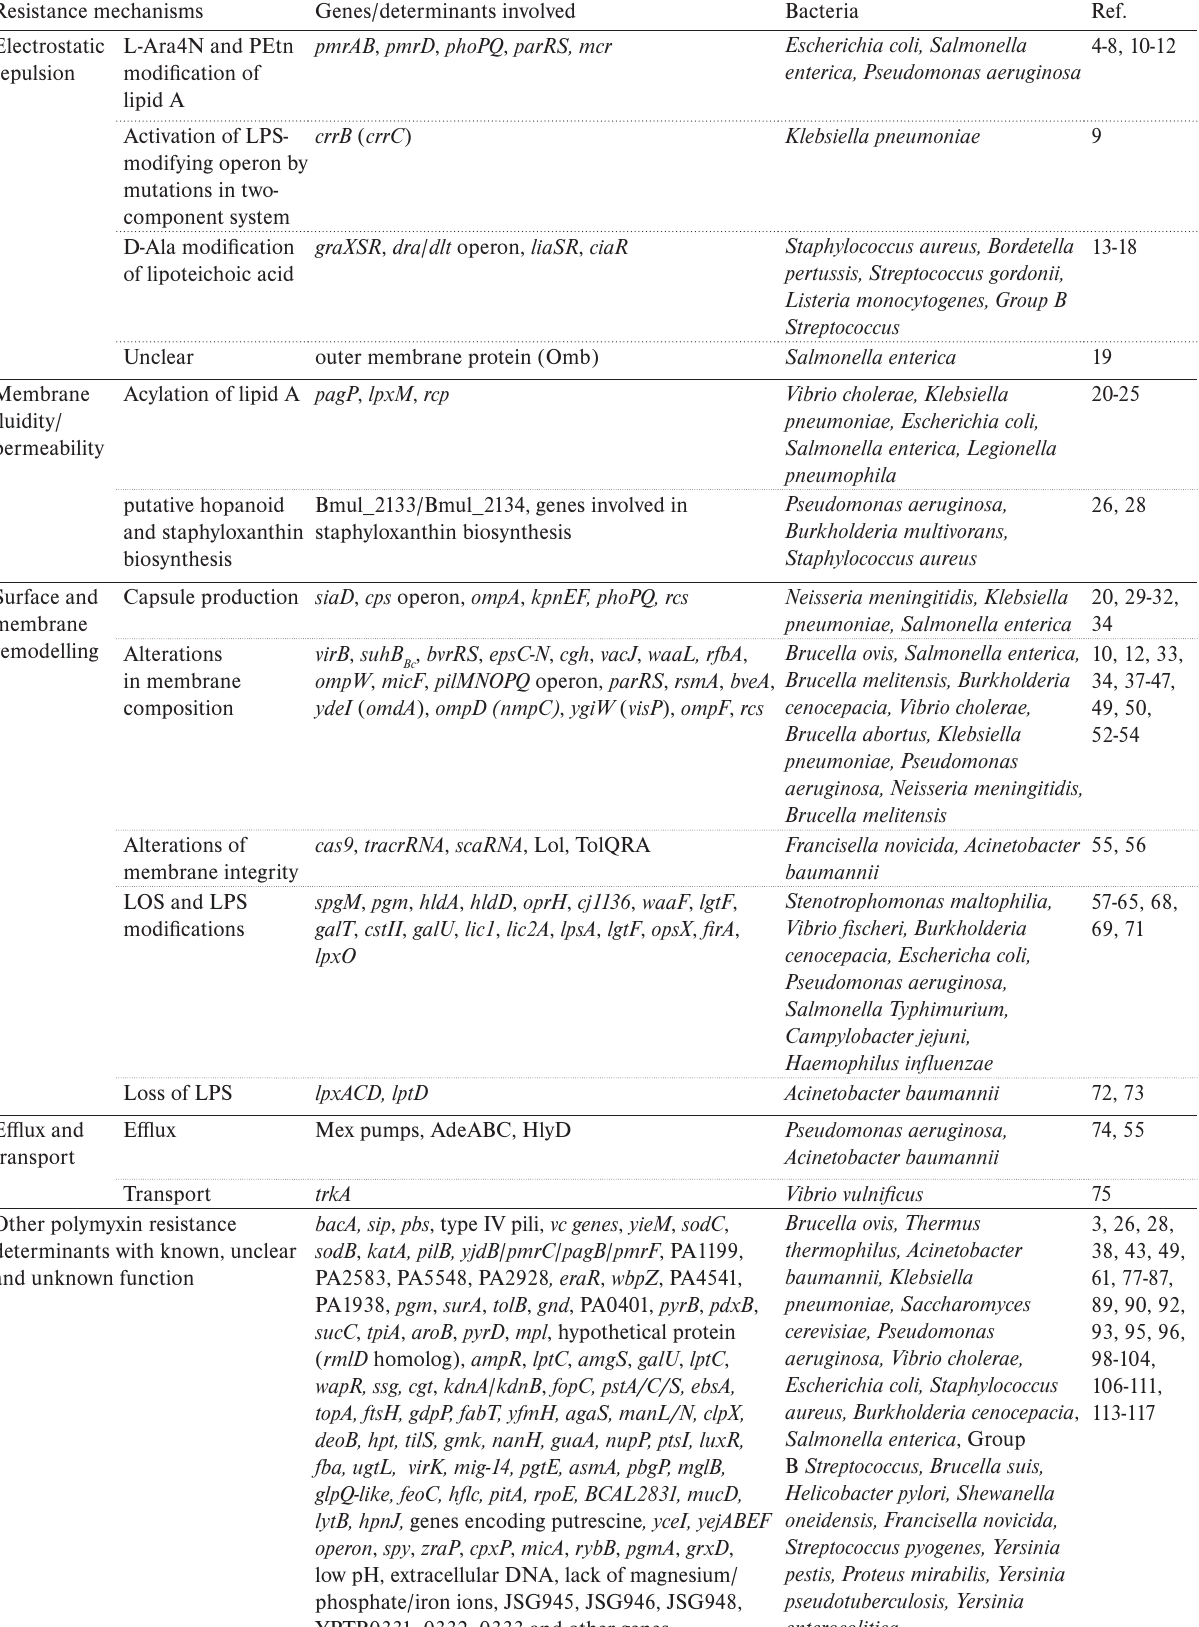
Table 2. Strategies used by bacteria to achieve resistance to